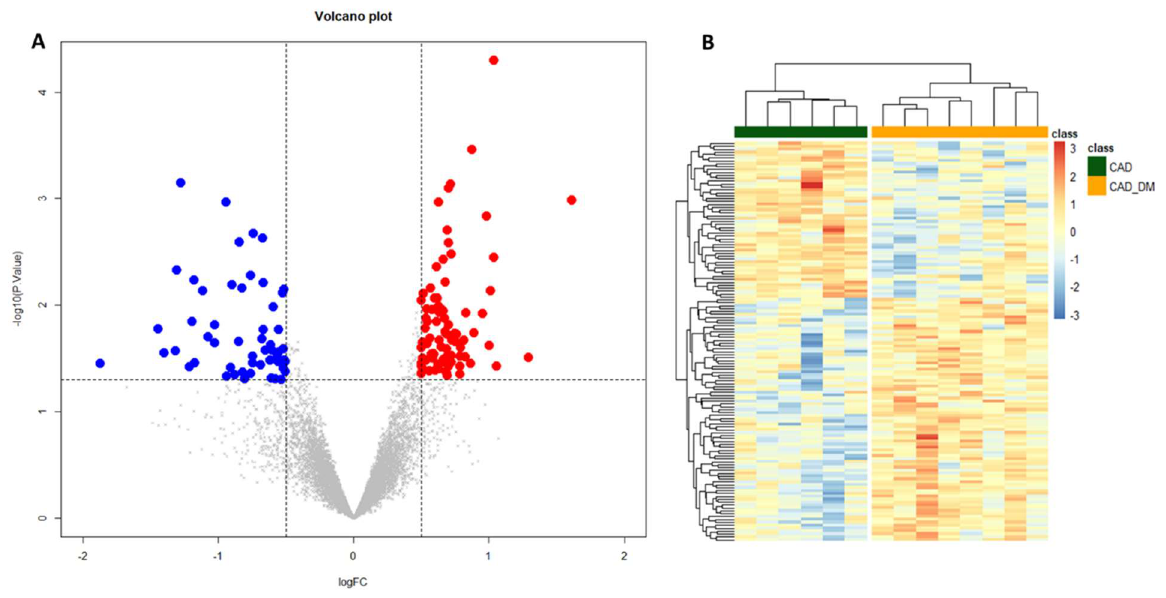
Figure 3. Volcano plot and Heatmap representation of differentially expressed genes. ( A ) The statistical analysis results are represented as a volcano plot of log2 fold-change (CAD-DM vs. CAD, x-axis) versus − log10 P values (y-axis). Among the 139 differentially expressed genes ( p < 0.05), 84 genes were over-expressed ( p -value < 0.05 and |log2 FC| > 0.5) in CAD-DM (red dots), whereas 55 in CAD (blue dots). ( B ) The heatmap shows that clustering based on the differentially expressed genes allowed complete separation between CAD-DM (orange squares) and CAD (green squares) samples. Gene expression levels were standardized and displayed as gradient colors from higher (dark orange) to lower (dark blue).